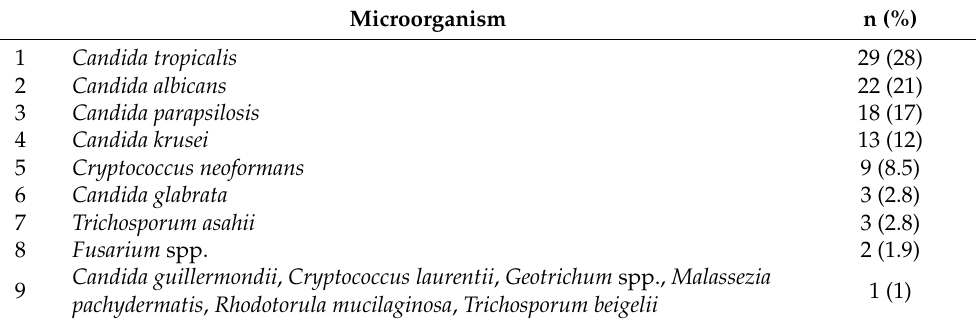
Table 3. Identified